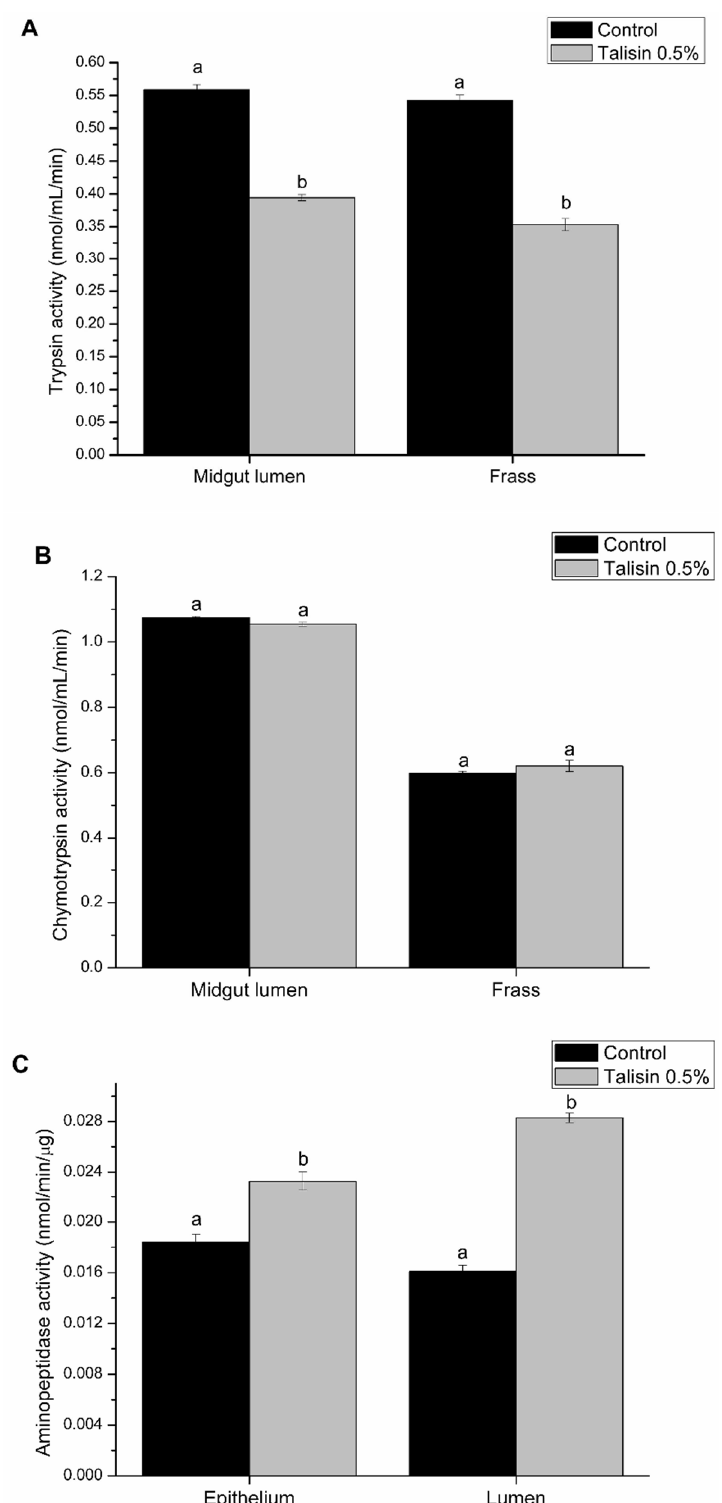
Figure 2. Trypsin-like ( A ), chymotrypsin-like ( B ) and aminopeptidase ( C ) activities in control and experimental (0.5% talisin-fed) Spodoptera frugiperda larvae. Different letters indicate significant differences ( p < 0.05; Tukey’s test).